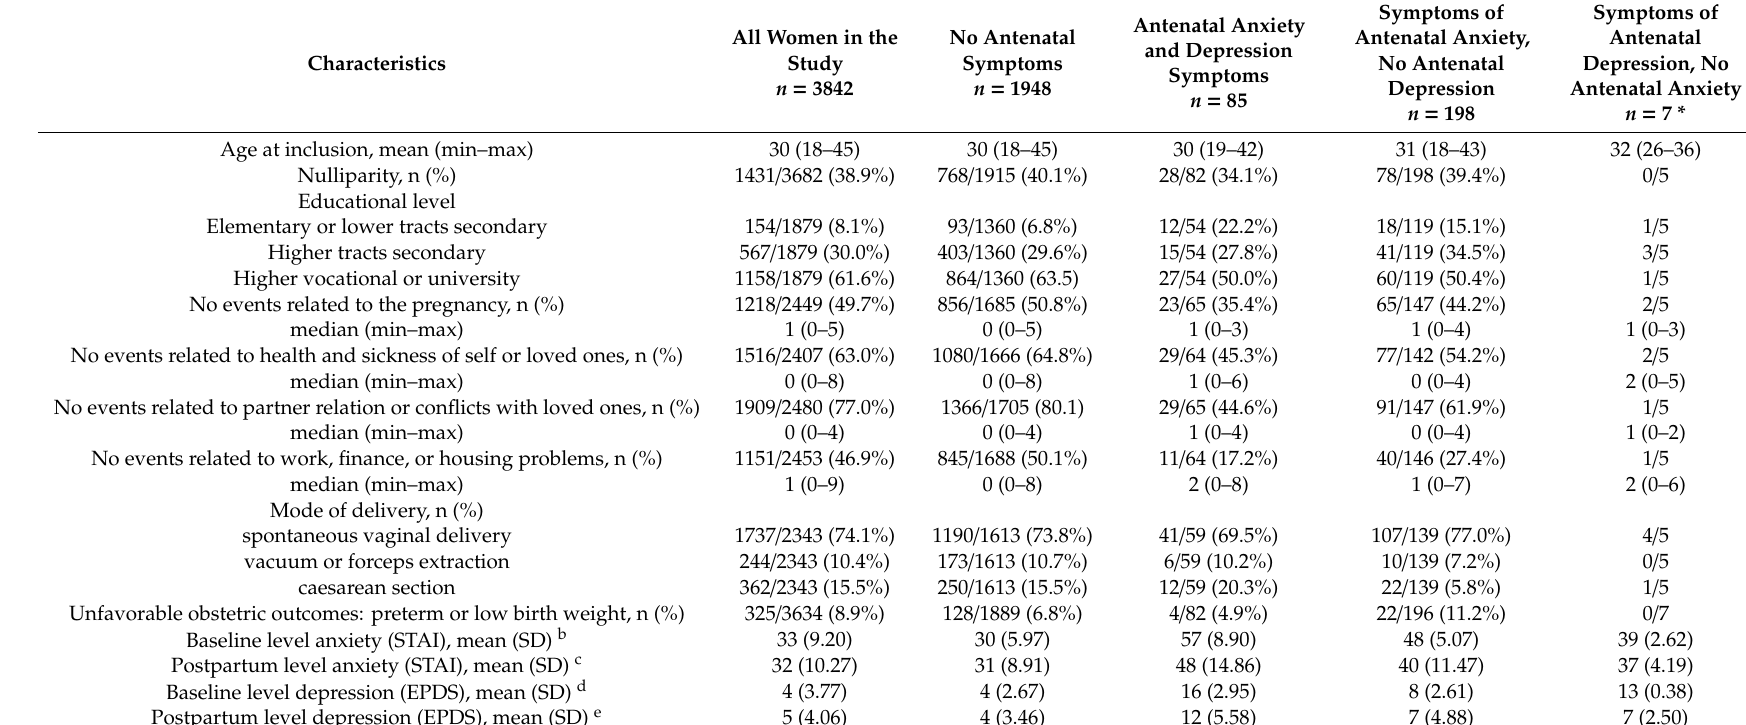
Table 1. Characteristics of women in the